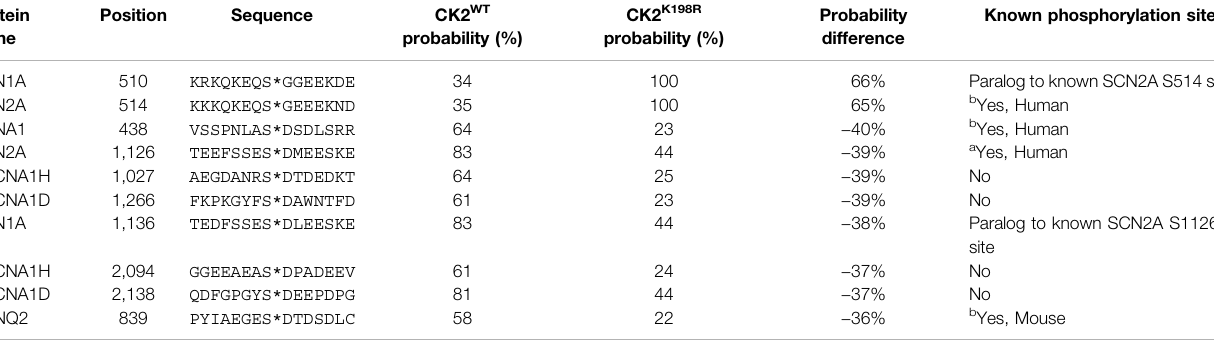
TABLE 1 | Top ten phosphorylation sites predicted to be most differentially phosphorylated by CK2 WT and CK2 K198R in axonally localized human ion